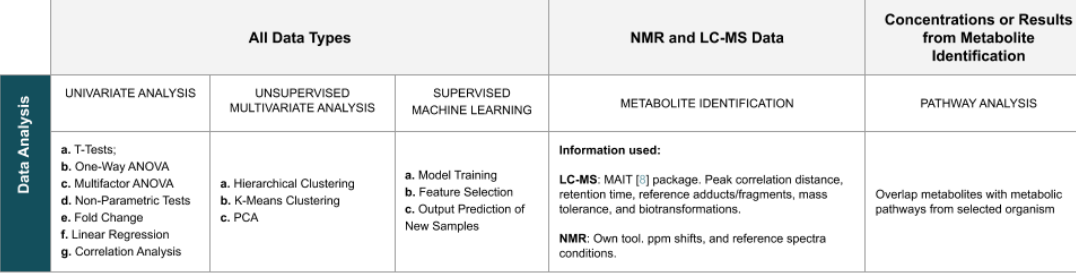
Figure 3. Summary of the WebSpecmine ’s data analysis